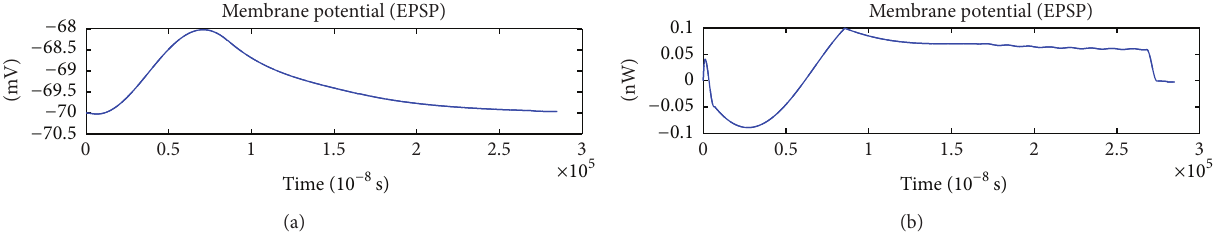
Figure 3: EPSP and its corresponding energy function. 𝑟 0𝑚 = 0.0001 Ω , 𝑟 1𝑚 = 0.1Ω , 𝑟 2𝑚 = 1000 Ω , 𝑟 3𝑚 = 0.1 Ω , 𝑟 𝑚 = 1000 Ω , 𝐶 𝑚 = 1 𝜇 F, = 50 𝜇 H, and 𝑖 = 7.155 𝜇 A. 𝐿 𝑚 0𝑚